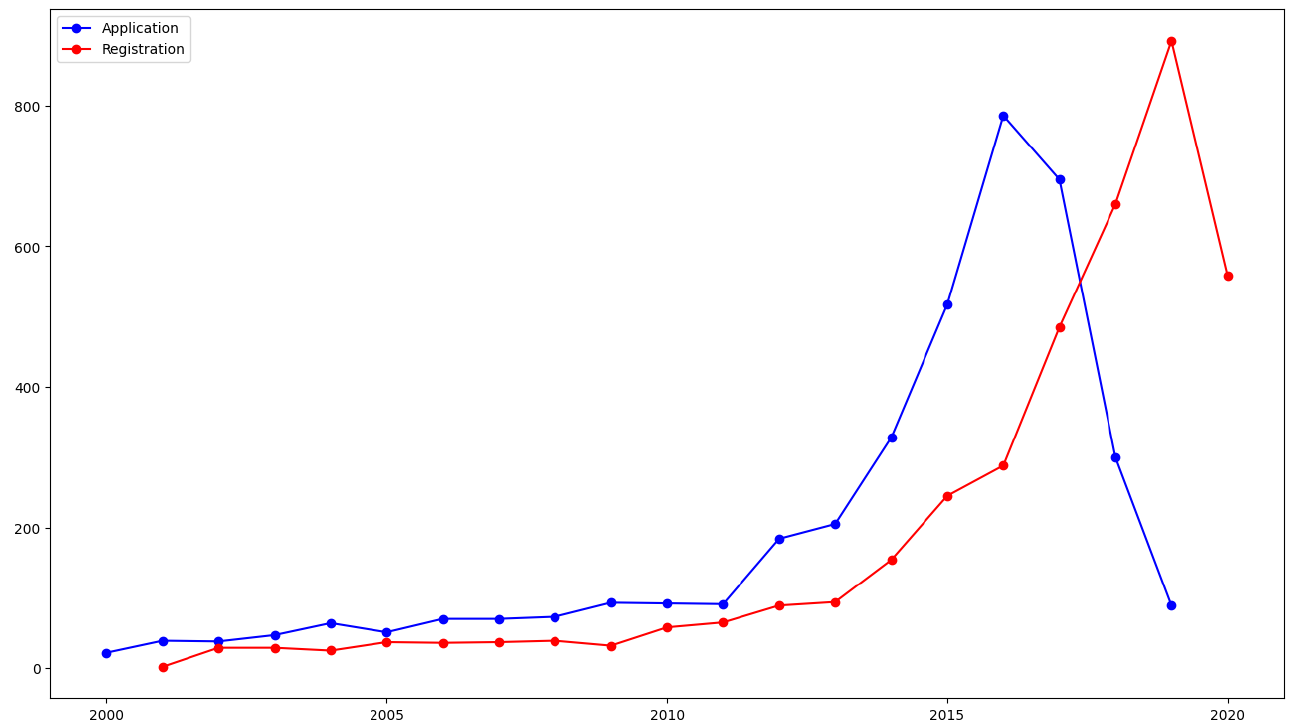
Figure 5. Drone patent applications and registrations trends per annum.